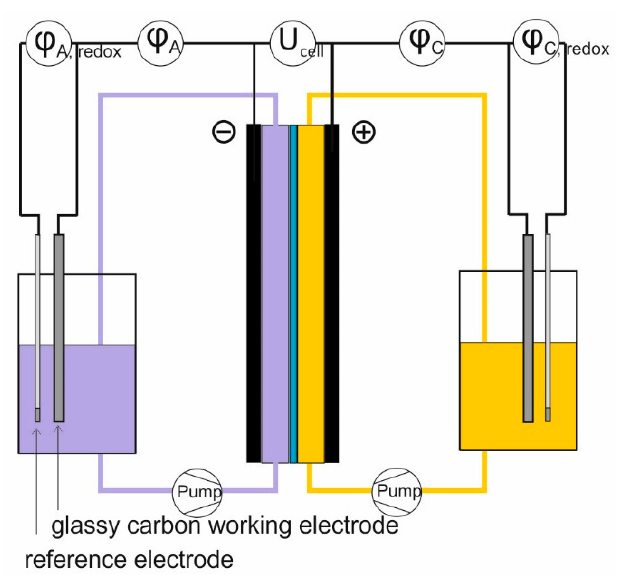
Figure 6. Schematic diagram of the electrodes connection for the cell test used to measure the cathodic ( ϕ C, redox ) and anodic ( ϕ A, redox ) redox potentials, cathodic ( ϕ C ) and anodic ( ϕ A ) half-cell potentials, and cell voltage (U cell ).